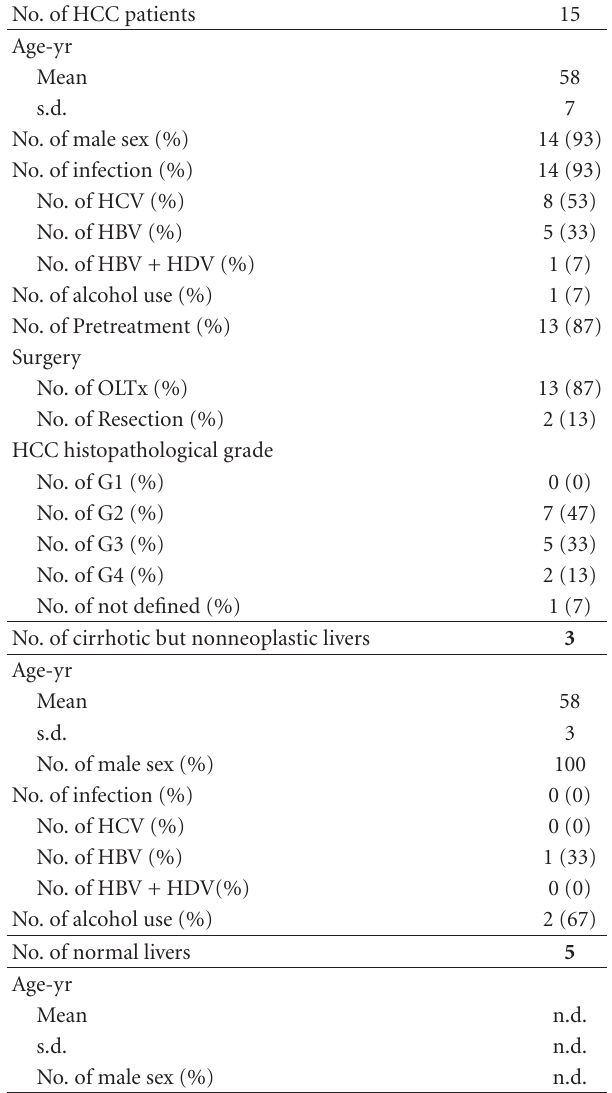
Table 1: Clinical-pathological characteristics, HCC: hepatocellular carcinoma, N.D .: not determined, pre-treatment: transarterial